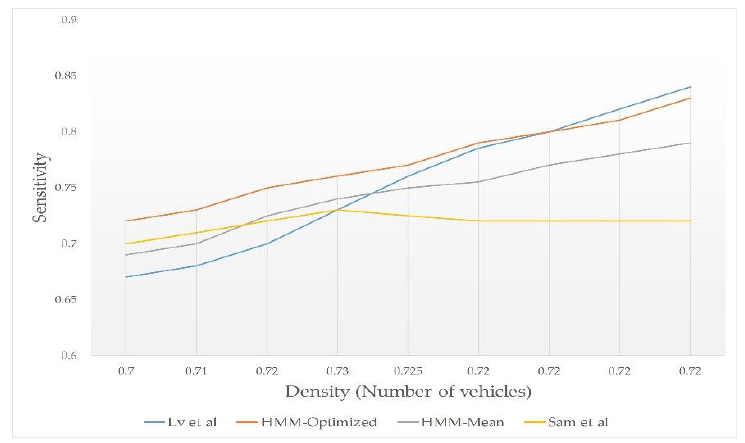
Figure 10. Density versus Sensitivity. Information 2018 , 9 , x FOR PEER REVIEW